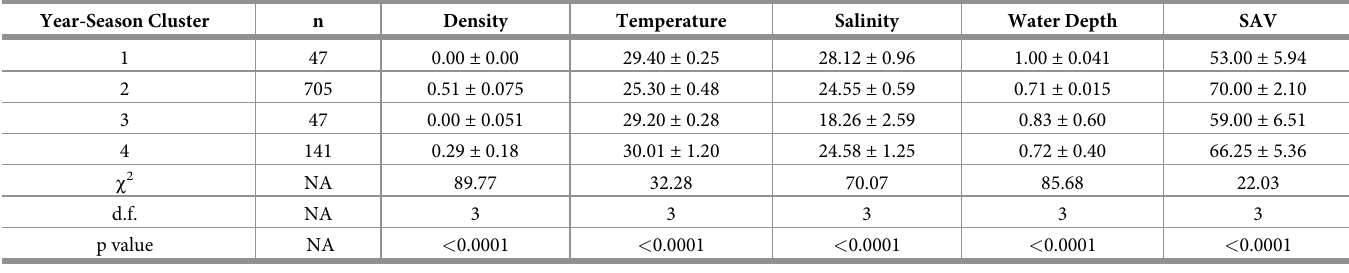
Median CI computed as described in the text. Values in depicted in Fig